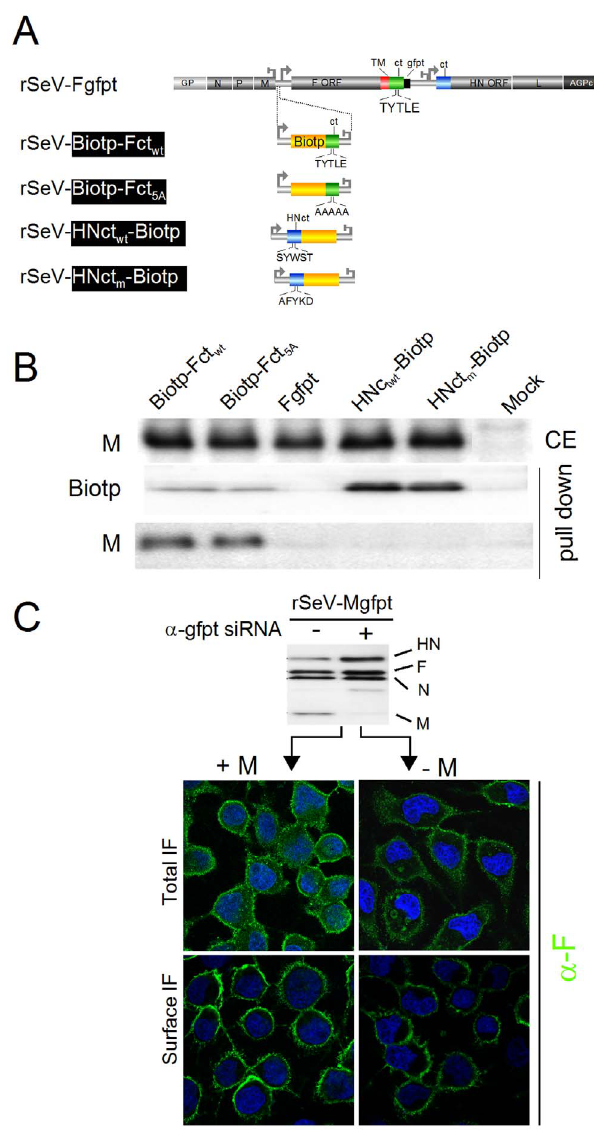
Figure 2. F-M interactions and movement dependency. A . Outline of recombinant SeV’s harbouring an additional transcription unit expressing the F cytoplasmic tail (ct, green) in its wt (Fct wt ) or mutated (Fct 5A )configurationfusedtoapeptidecontainingabiotinylationsite(Biotp, yellow). Corresponding constructs, harbouring the HN cytoplasmic tail (ct, blue) are equally shown, carrying the wt sequence (HNct wt ) or a mutation in the SYWST motif (HNct m , [11]) Fgfpt: as in figure 1. Note that the endogenous wt-F is open to conditional suppression by a -gfpt siRNA. B . a - gfpt siRNA expressing MDCK were infected with the indicated viruses in medium supplemented with 1 mg/ml of biotin. Thirty hours post infection cellular extracts were prepared and incubated with streptavidin agarose resins to pull down Fct and HNct fused to Biotp. Upper panel: Western blot analysis recording cellular levels of M (CE). Lower panels: Western blot analysis of the pull down samples probed with a -M, a -Fct or a -HNct (pull down). C . MDCK cells expressing or not a -gfpt siRNA ( + / 2 ) were infected with rSeV-Mgfpt, a recombinant virus expressing a M protein open to conditional suppression [15]. The infected cells were either grown in Petri dishes for cellular extract preparation or seeded on coverslips for confocal imaging. Upper panel: Western blot analysis of the cellular extracts prepared 36 hours post infection using an antibody cocktail shown in figure 3 to document M protein suppression. Lower panels: Confocal images of HA-F obtained before (Surface IF) or after (Total IF) cell permeabilization with a -F as primary